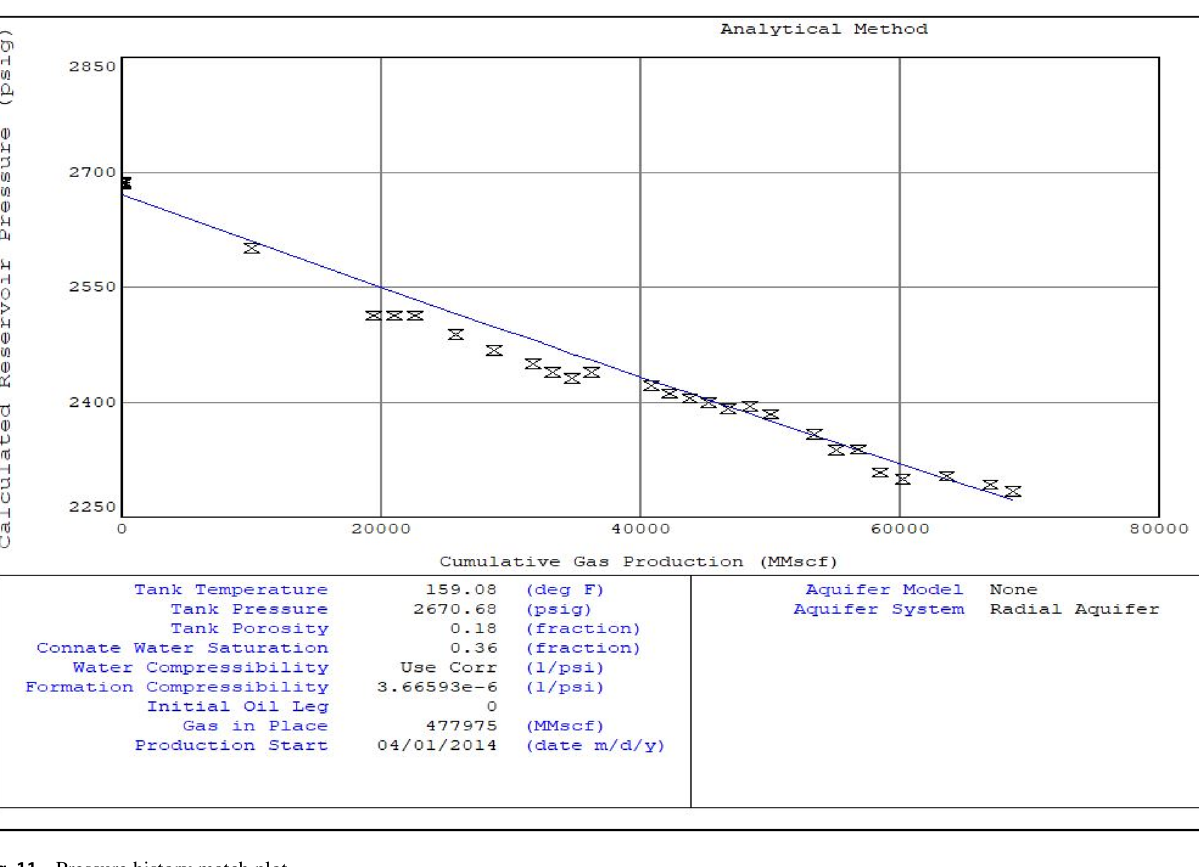
Fig. 11 Pressure history match plot